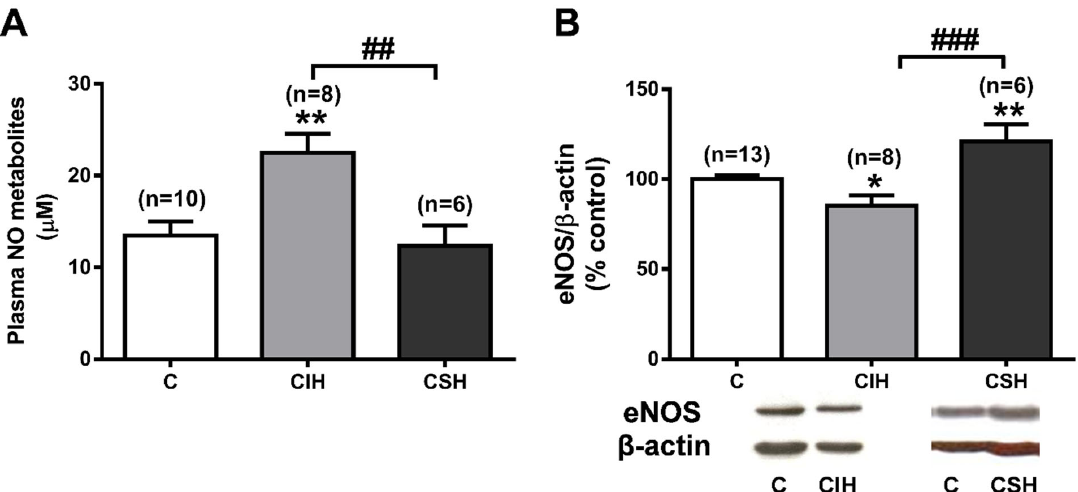
Figure 4. NO metabolites plasma levels and eNOS expression (WB) in pulmonary arteries. ( A ) Plasma levels of nitrite/nitrates, expressed in µ M, in C, CIH, and CSH. Data are means ± SEM from n = 6–12 rats. ** p < 0.01 vs. C animals, one-way ANOVA with Tukey multi comparison test; ## p < 0.01 CIH vs. CSH unpaired t -test. ( B ) Representative Western blot obtained with eNOS antibody (dilution 1:500) showing a single band of expected molecular weight (130 kDa) in PA from C, CIH, and CSH. Optical densities of eNOS were quantified, normalized relative to β -actin signal (eNOS/ β -actin), averaged for all the replicated gels, and expressed as % of the control arteries (set as 100%), in CIH and CSH pulmonary arteries. Values are mean ± SEM ( n = 6–8 arteries); * p < 0.05 vs. C; ### p < 0.001 CIH vs. CSH; one-way ANOVA with Tukey multi comparison test.